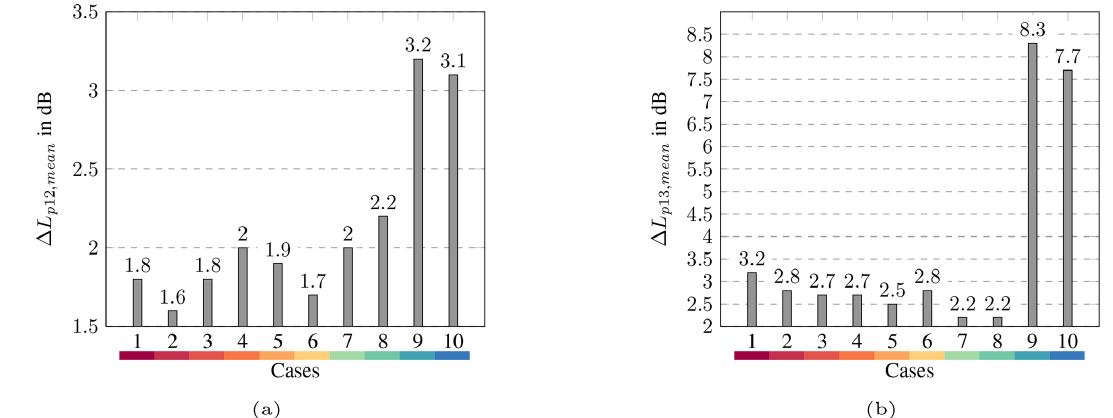
Figure 10. Difference of measured and modelled overall propagation losses between (a) Mic 1 (178m) and Mic 2 (535m) and between (b) Mic 1 (178m) and Mic 3 (845m).